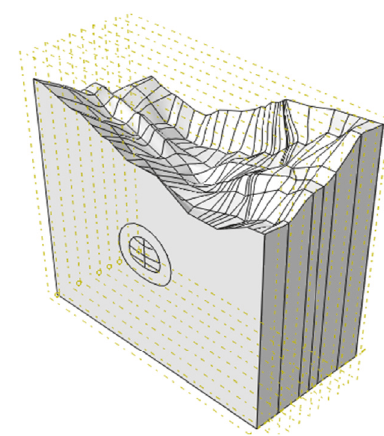
Figure 5: Mesh division.